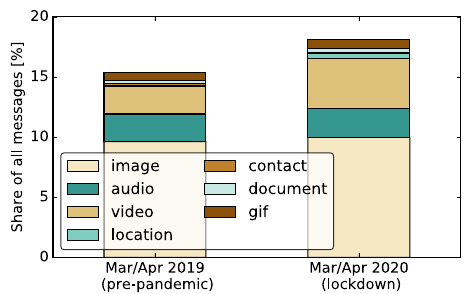
Fig. 3 Difference in average number of messages per day per chat. The fi gure shows the CDF of the percentage of the average number of messages per day per chat from the Mar/Apr 2020 lockdown period compared to the Mar/Apr 2019 pre-pandemic period.